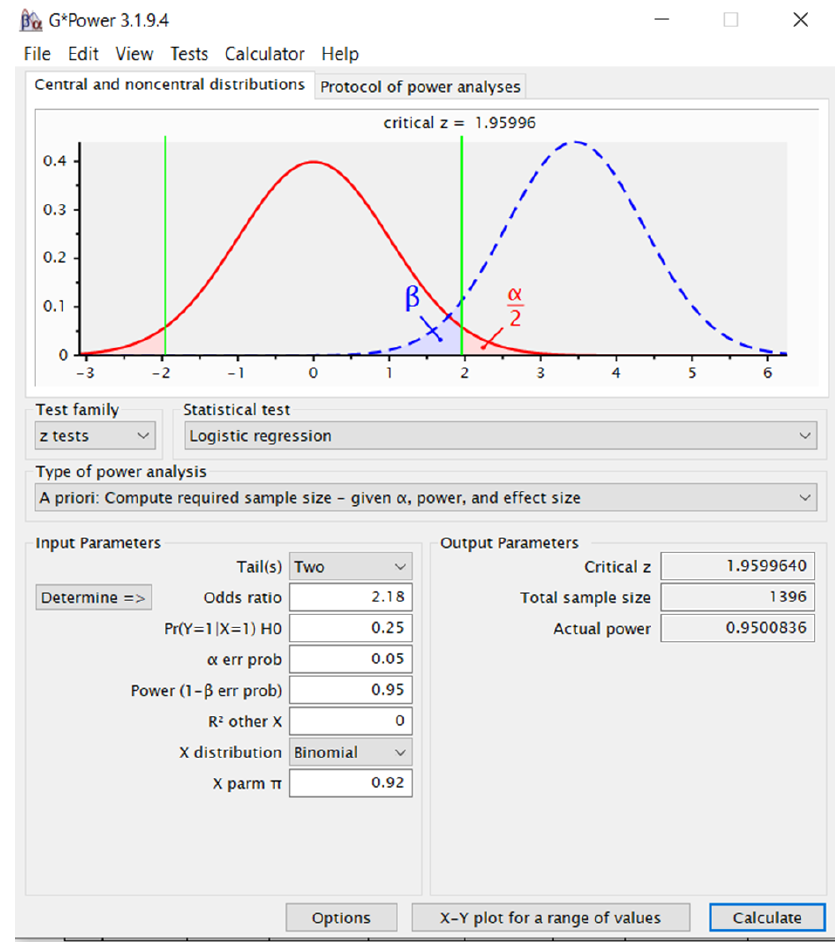
Figure A1. G* power sample size output.